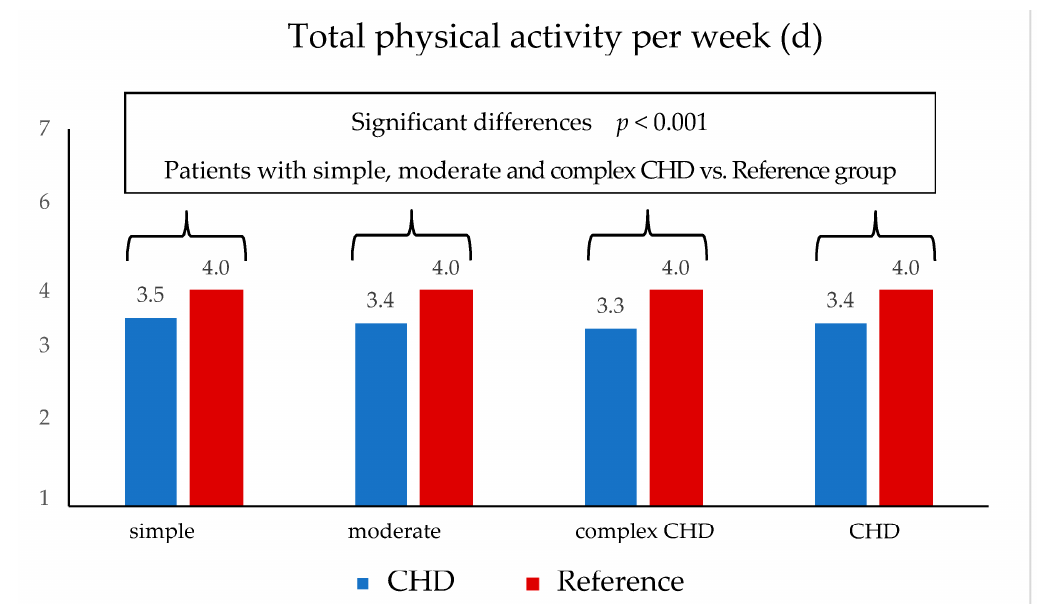
Figure 1. Total physical activity in days per week (patients vs. reference).